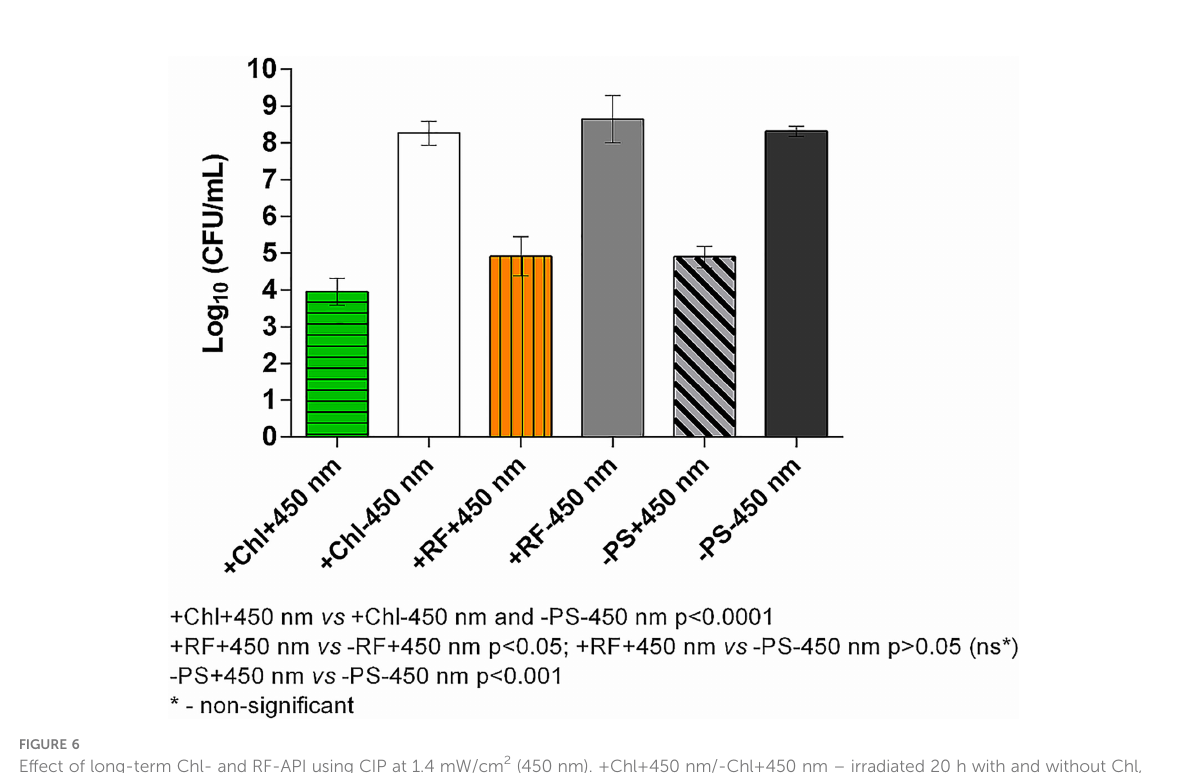
FIGURE 6 Effect of long-term Chl- and RF-API using CIP at 1.4 mW/cm 2 (450 nm). +Chl+450 nm/-Chl+450 nm – irradiated 20 h with and without Chl, respectively; +RF+450 nm/-RF+450 nm – irradiated 28 h with and without RF, respectively; -PS+450 nm/-PS-450 nm – irradiated and not irradiated 20-28 h without PSs (Chl or RF),